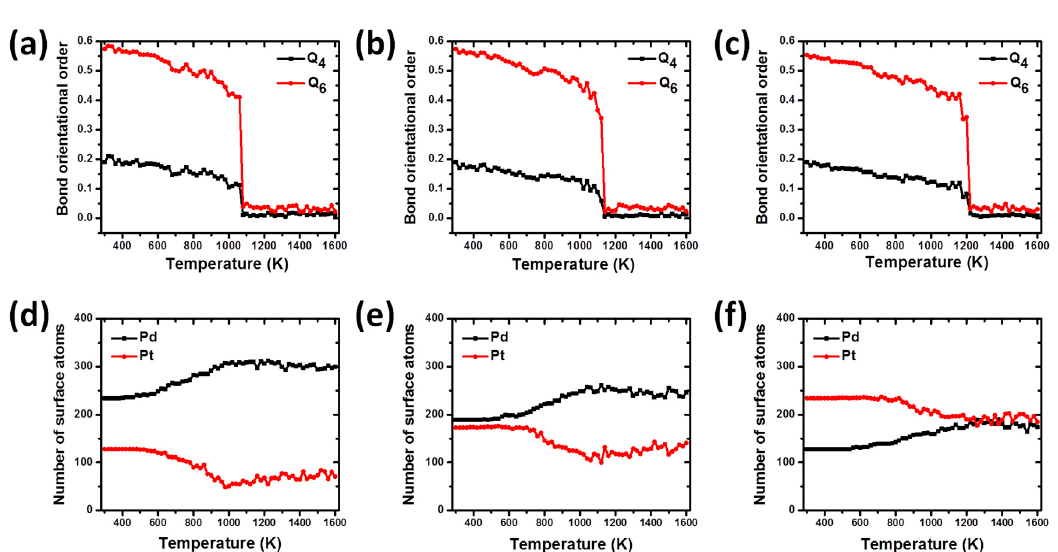
Figure 4. ( a – c ) Temperature-dependent bond order parameter, and ( d – f ) number of surface atoms, for the bimetallic nanoparticles PdPt (2:1), PdPt (1:1), and PdPt (1:2),